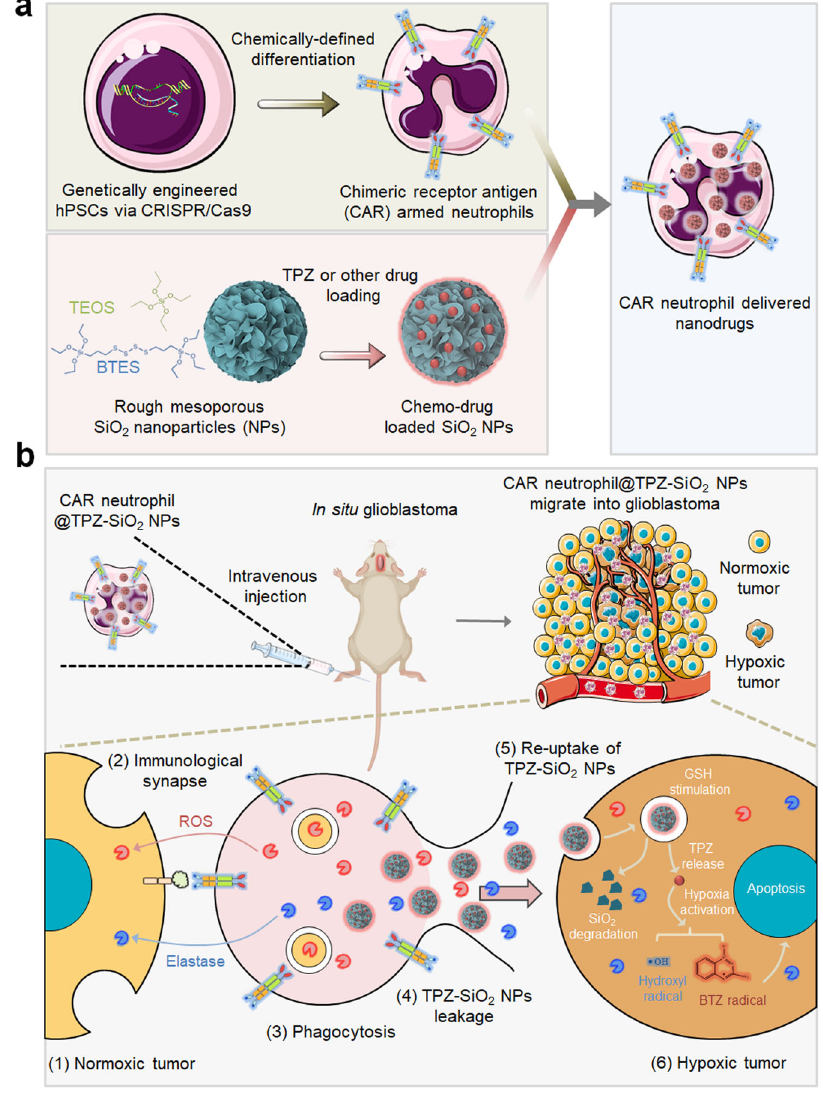
Fig. 1 | Schematic of enhanced anti-glioblastoma ef fi cacy using combinatory immunotherapyofCAR-neutrophilsandtumormicroenvironmentresponsive nanodrugs. a Human pluripotent stem cells were engineered with CARs and dif- ferentiated into CAR-neutrophils that are loaded with rough silica nanoparticles (SiO 2 NPs) containing hypoxia-targeting tirapazamine (TPZ) or other drugs, as a dualimmunochemotherapy. b SystemicallyadministeredCAR-neutrophil@R-SiO 2 -